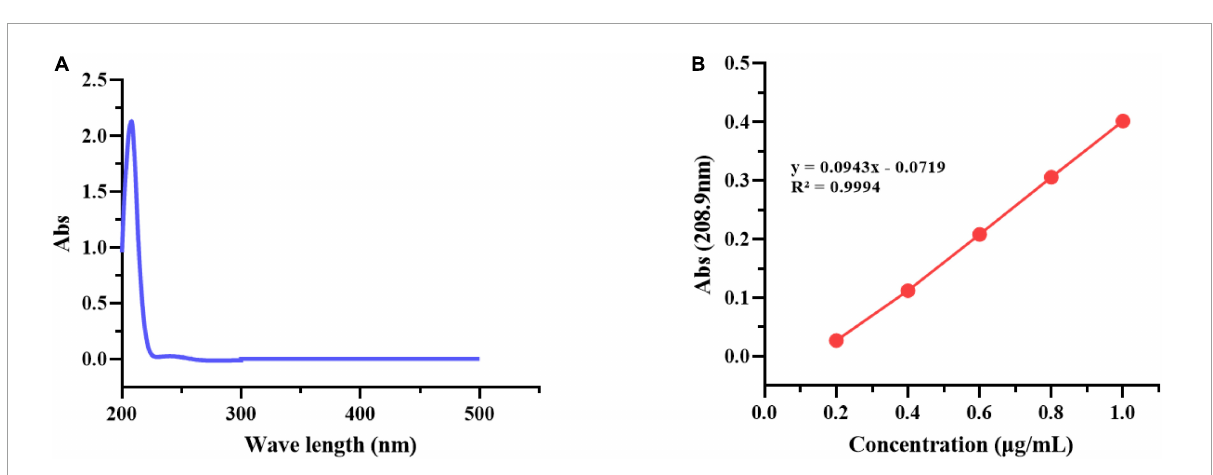
FIGURE4 UV absorption spectrum of geraniol (A) and Standard curve of geraniol (B)